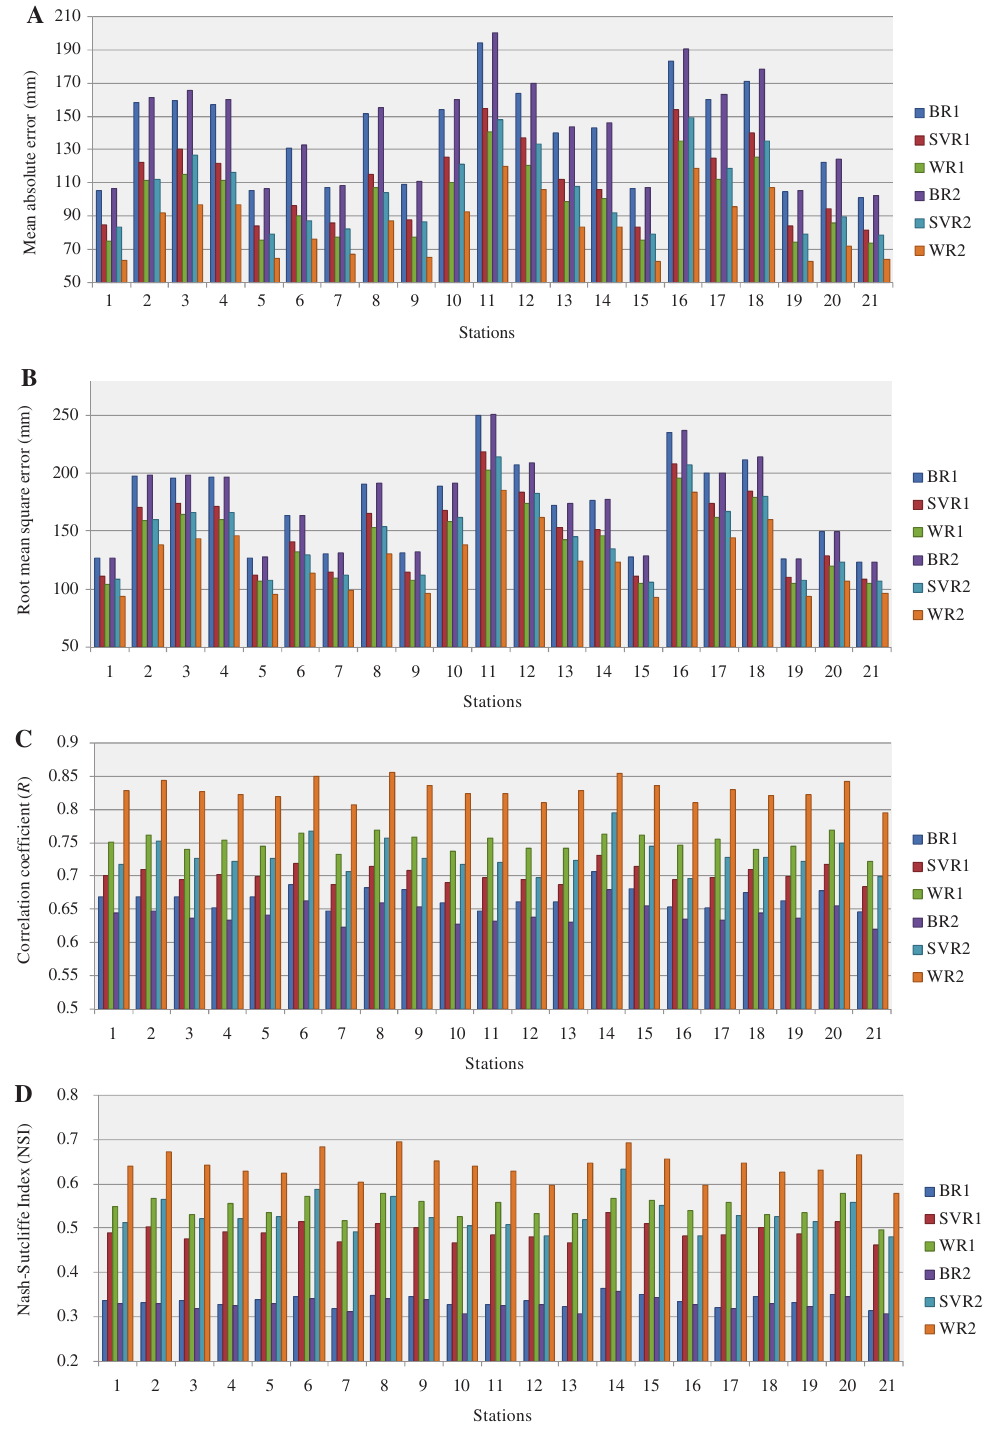
Figure 6: (A) MAE for Different Models at 21 Stations. (B) RMSE for Different Models at 21 Stations. (C) Correlation Coefficient ( R ) for Different Models at 21 Stations. (D) Nash-Sutcliffe Index (NS) for Different Models at 21 Stations.